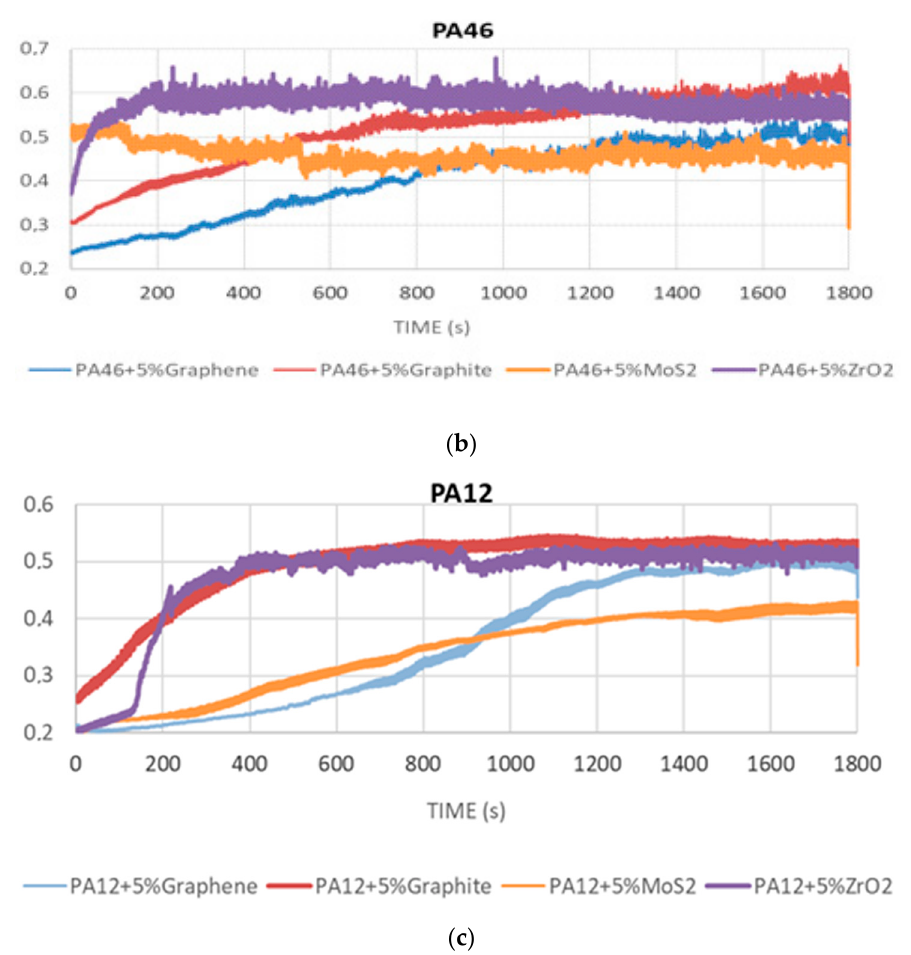
Figure 2. CoF evolution for composites based on ( a ) PA66, ( b ) PA46, and ( c ) PA12.